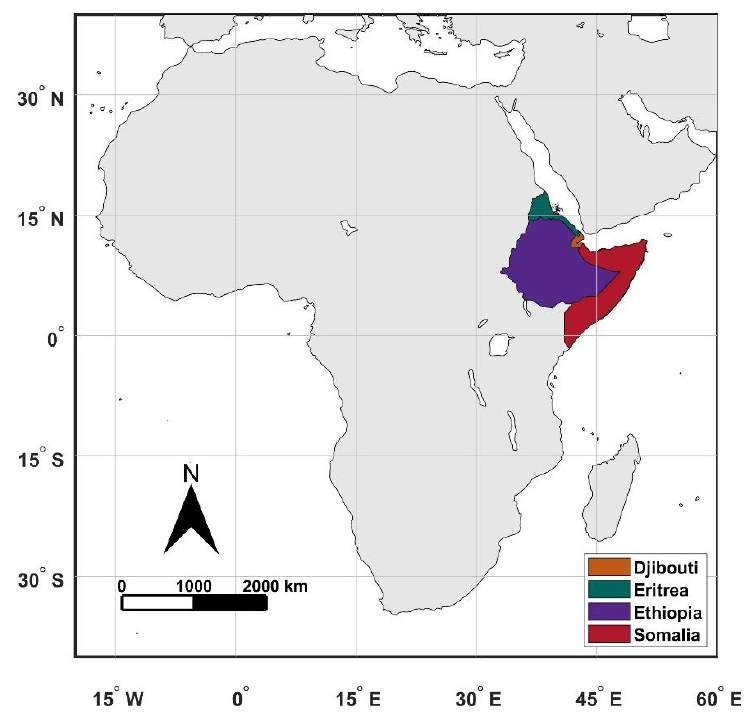
Figure 1. Map of the Horn of Africa (HOA), the selected study